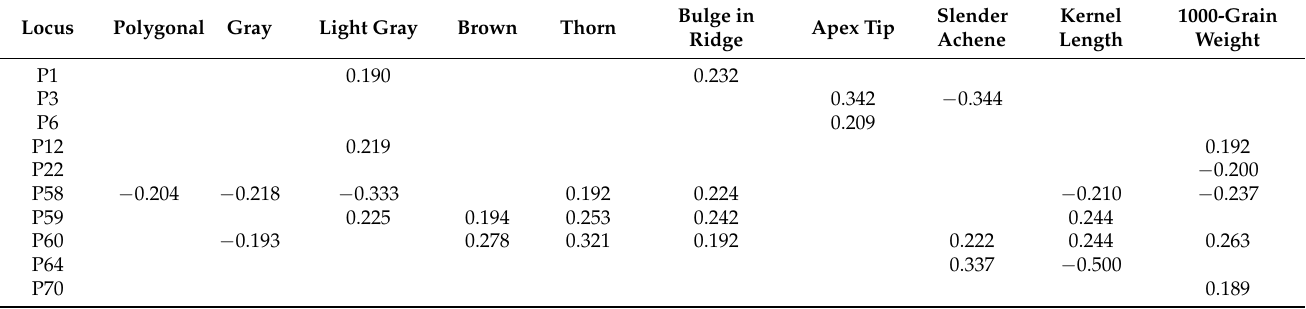
Table 4. SSR marker loci associated with morphological traits ( p <